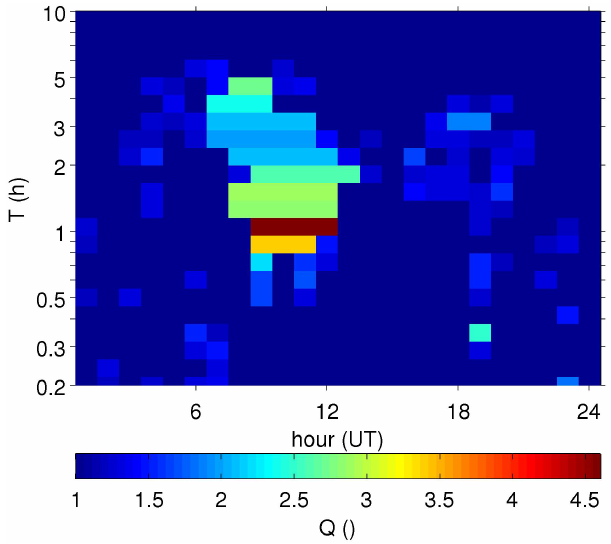
Figure 5. The quality factor Q resulting from the analysis of elec- tron density over the entire day, as a function of the period length T and the hour of the day t t .